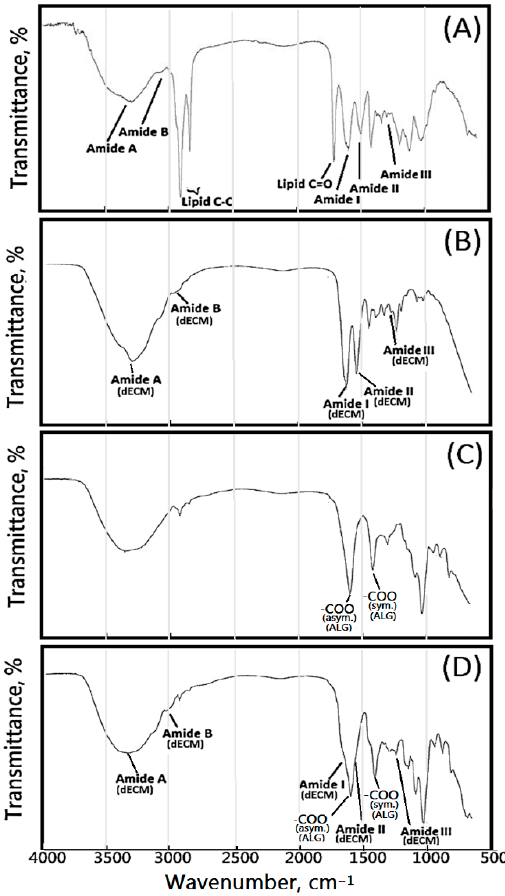
Figure 1. FTIR spectrum of the samples: ( A ) original porcine skin, ( B ) dECM, ( C ) AdE0N, and ( D ) cross-linked ALG/dECM composite scaffold membrane (AdE4H).